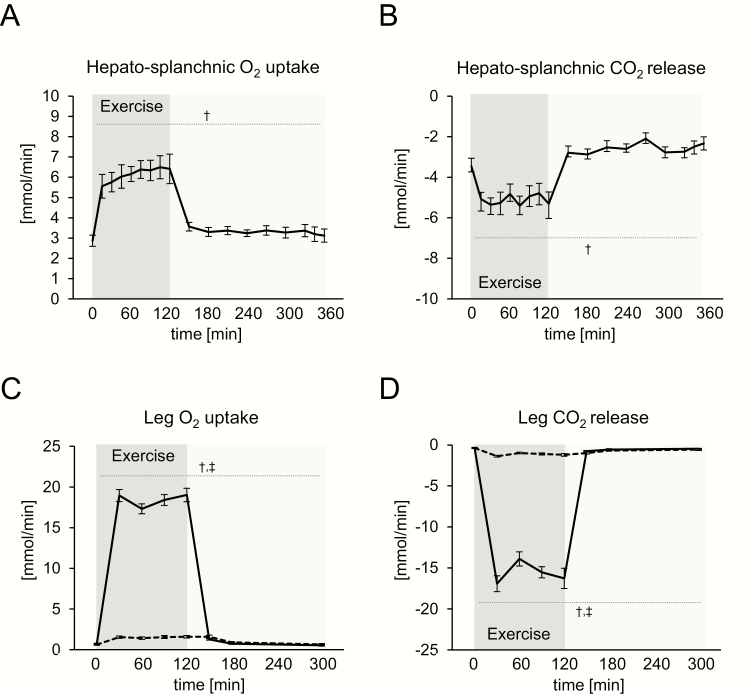
Blood gas fluxes in the hepato-splanchnic exercise study (1A, 1B) and one-legged knee extensor study (1C, 1D). 1A: Oxygen (O2) uptake and 1B: Carbon dioxide (CO2) release over the hepato-splanchnic bed. 1C: O2 uptake and 1D: CO2 release over the exercising (solid line) and resting leg (dashed line). Data are presented as mean ± standard error (SEM). † significant effect of time, ‡ significant effect of leg*time.